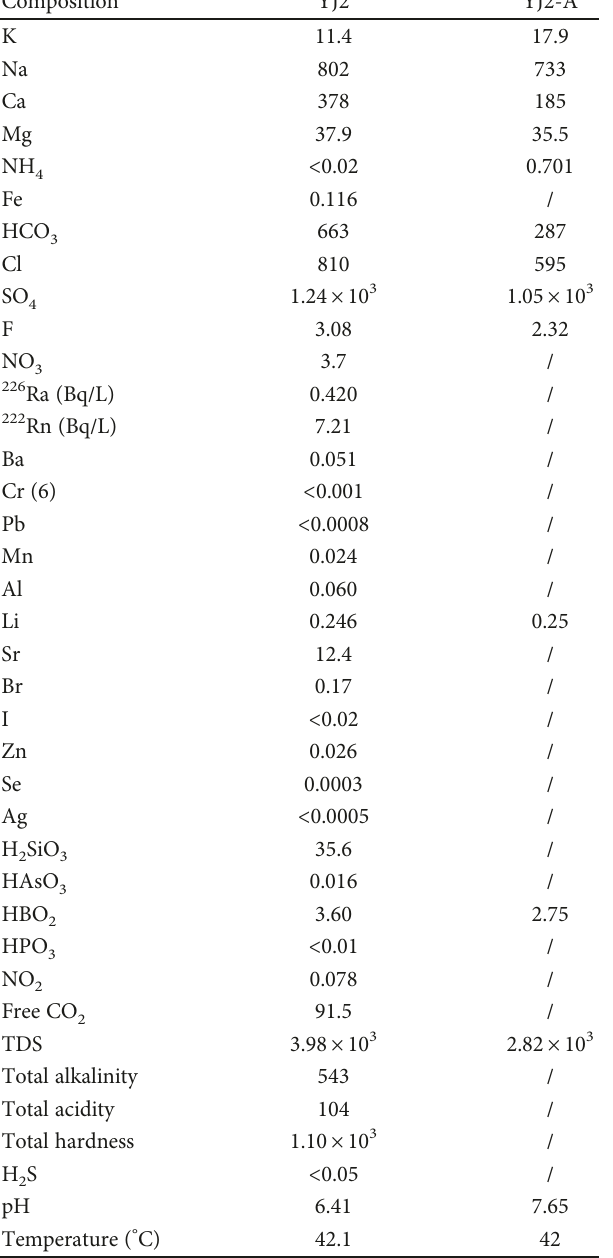
Table 1: Chemical analyses of the Madeng hot spring (mg/L).